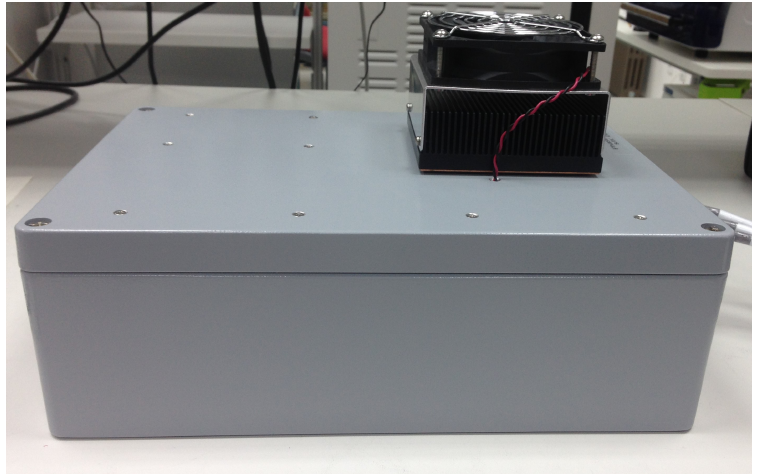
Figure 2. View of a phaseCal antenna unit (AU) enclosure, with a Peltier heat sink and associated